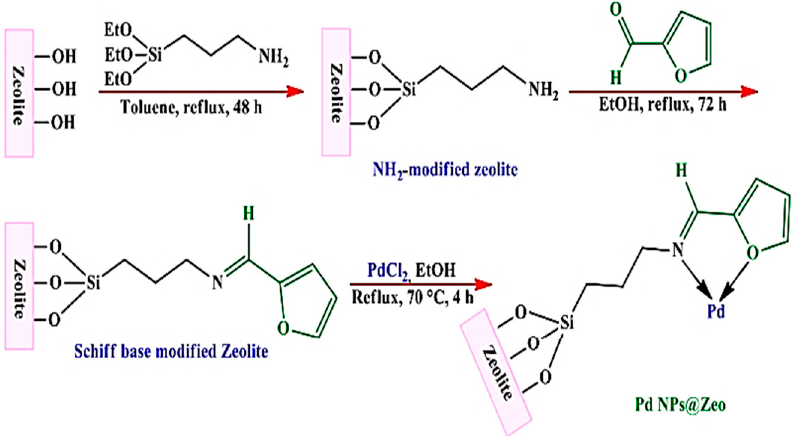
Figure 6. APTES for palladium immobilization at the zeolite surface. Reprinted from [100] with permission from Elsevier.